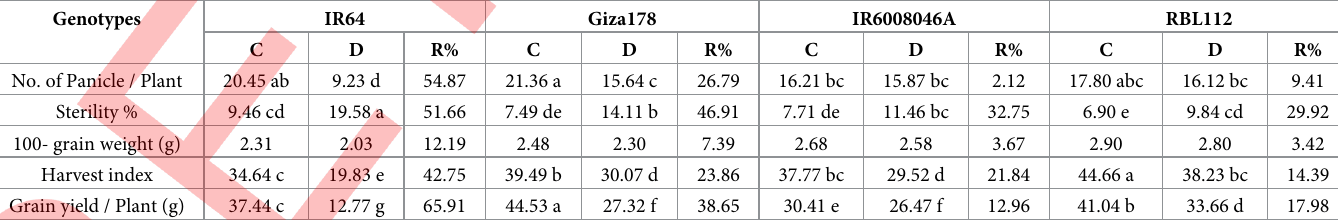
Table 3. Mean performance of the studied genotypes for yield and its components traits in both environments and their combined data during the two growing seasons. Genotypes No. of Panicle /